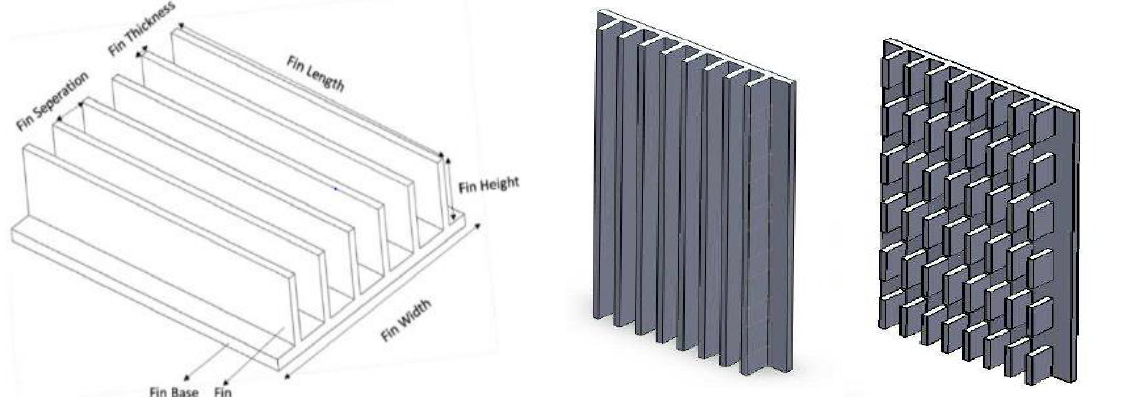
Figure 2. (a) Geometrical fin parameters (b) Continuous and Interrupted rectangular fin